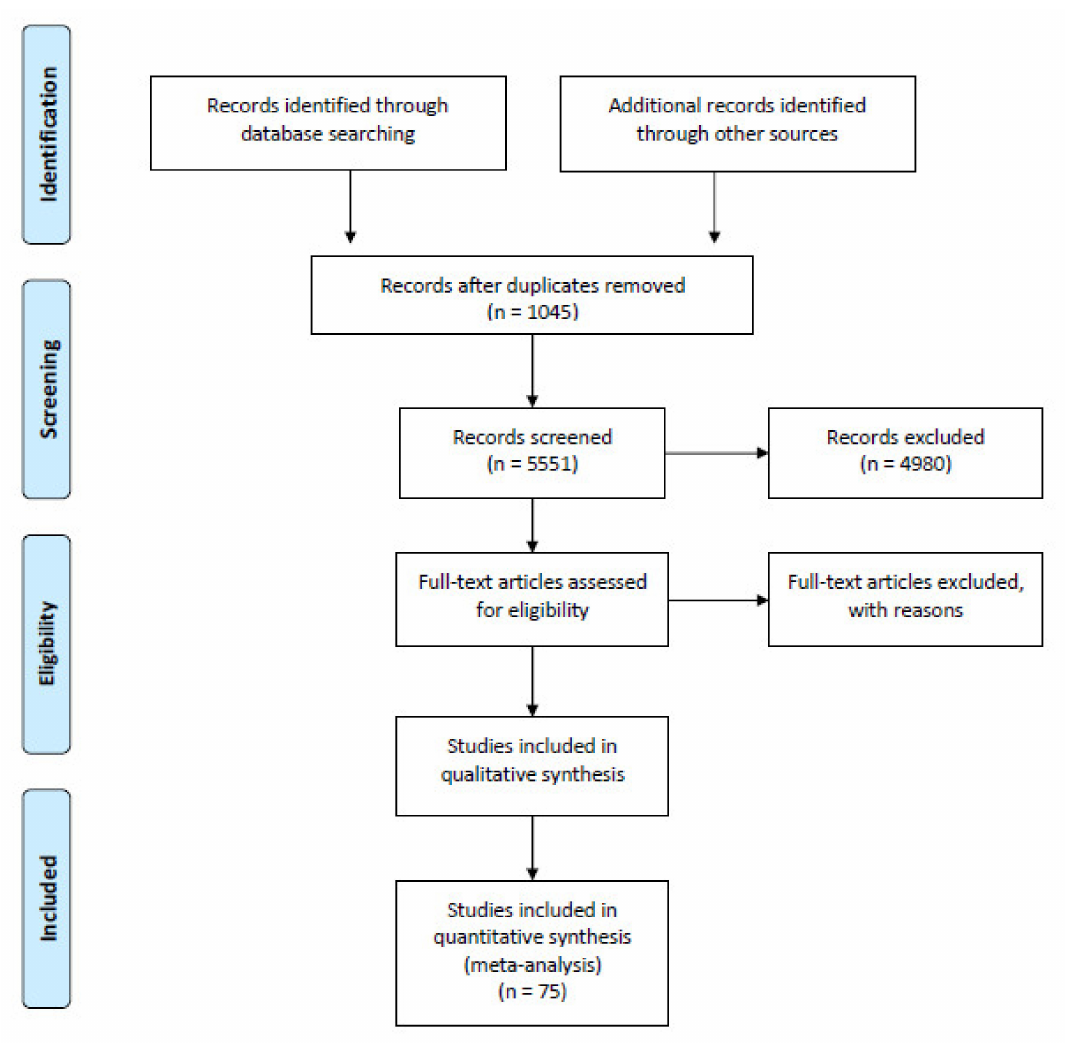
Figure 1. PRISMA 2009 flow